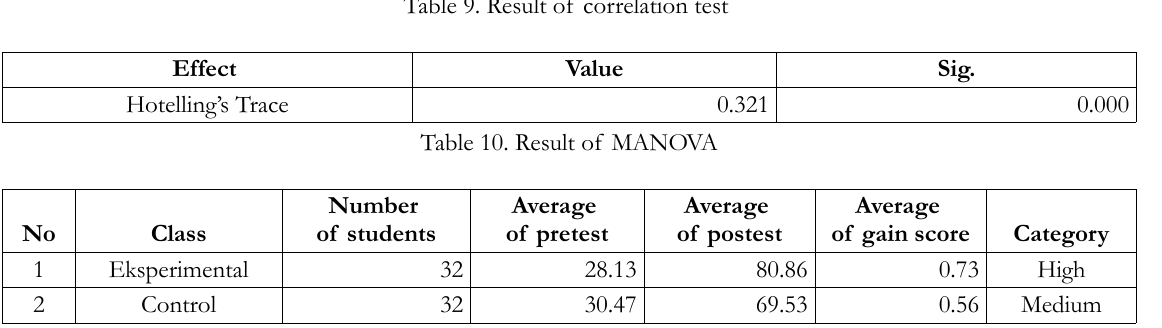
Table 11. Result of improvement in critical thinking abilities